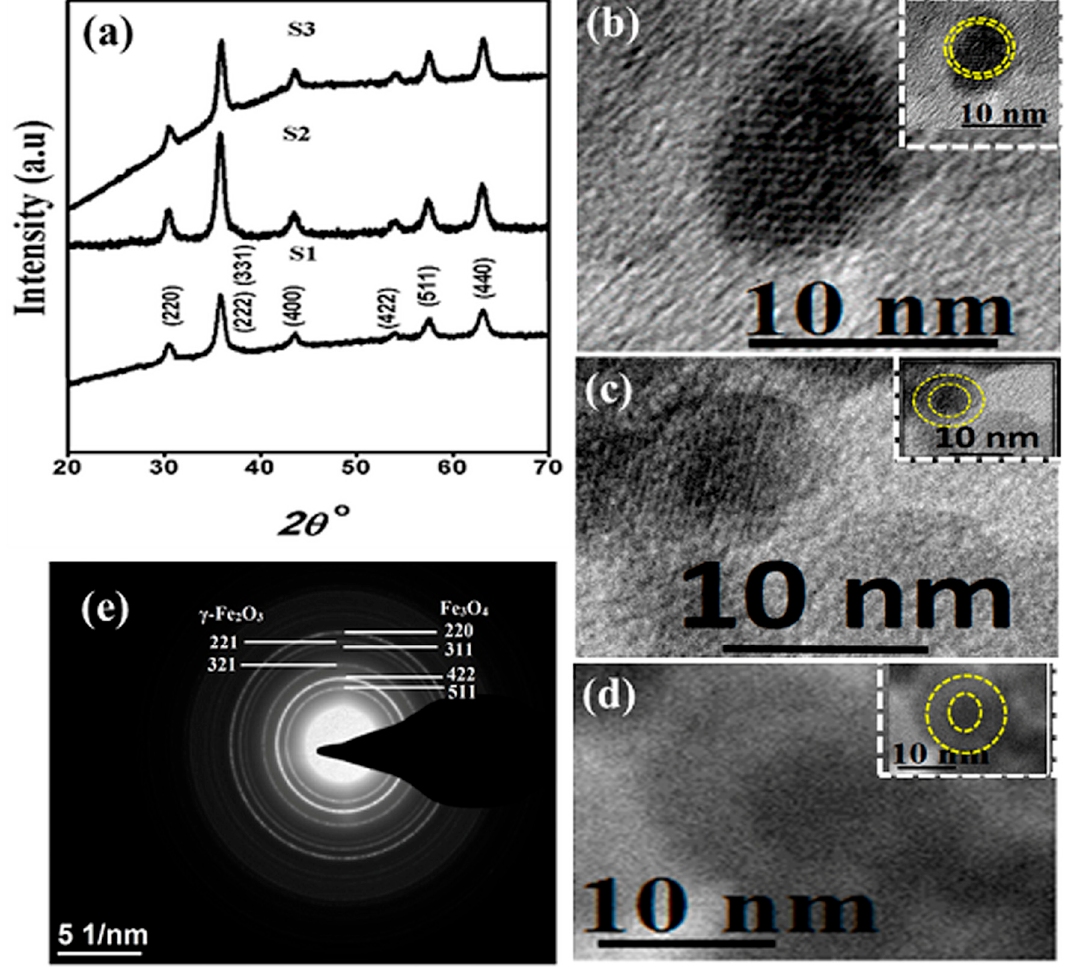
Figure 1. ( a ) The X-ray diffraction (XRD) patterns of Fe 3 O 4 / γ -Fe 2 O 3 core/shell nanoparticles for all samples; ( b ) the high-resolution transmission electron microscopy (HRTEM) image of sample S1; ( c ) the HRTEM image of sample S2 ( d ) the HRTEM image of sample S3; ( e ) selected area electron diffraction (SAED) images of sample S2. (Reproduced from [37]. Copyright Obaidat, I.M., et al., 2017.).